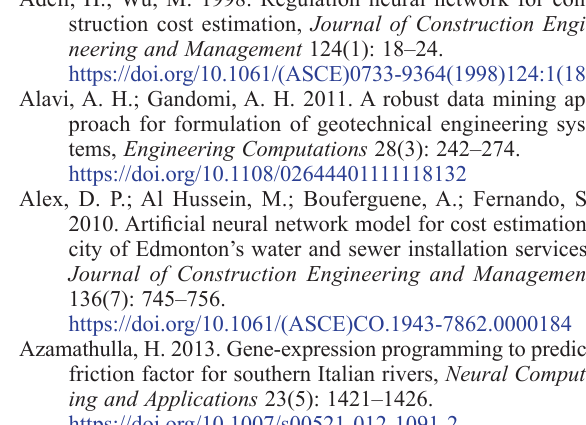
Fig. 6. Parametric analysis of cost estimate in the GP